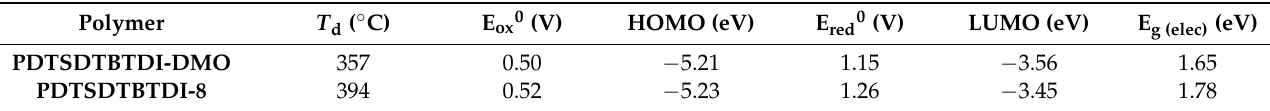
Figure 2. Cyclic voltammograms of PDTSDTBTDI-DMO and PDTSDTBTDI-8 on Pt electrode in Bu4NClO 4 /CH 3 CN. Table 3. Electrochemical and thermal properties of the